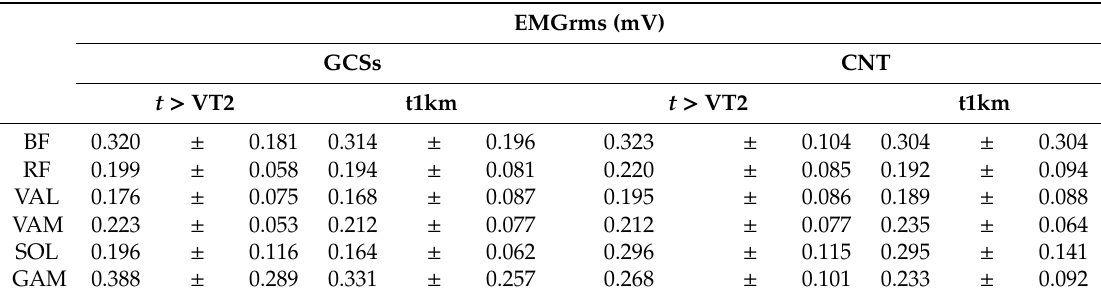
Table 1. EMG (electromyography) variables base on wearing or not wearing a graduate compression garment during the t > Vt2 and